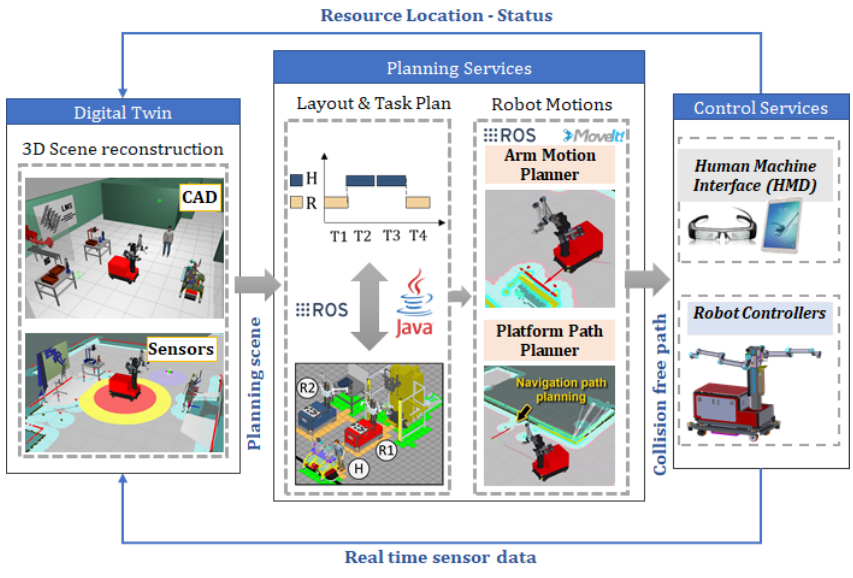
Figure 7. Digital Twin based re-design system architecture.